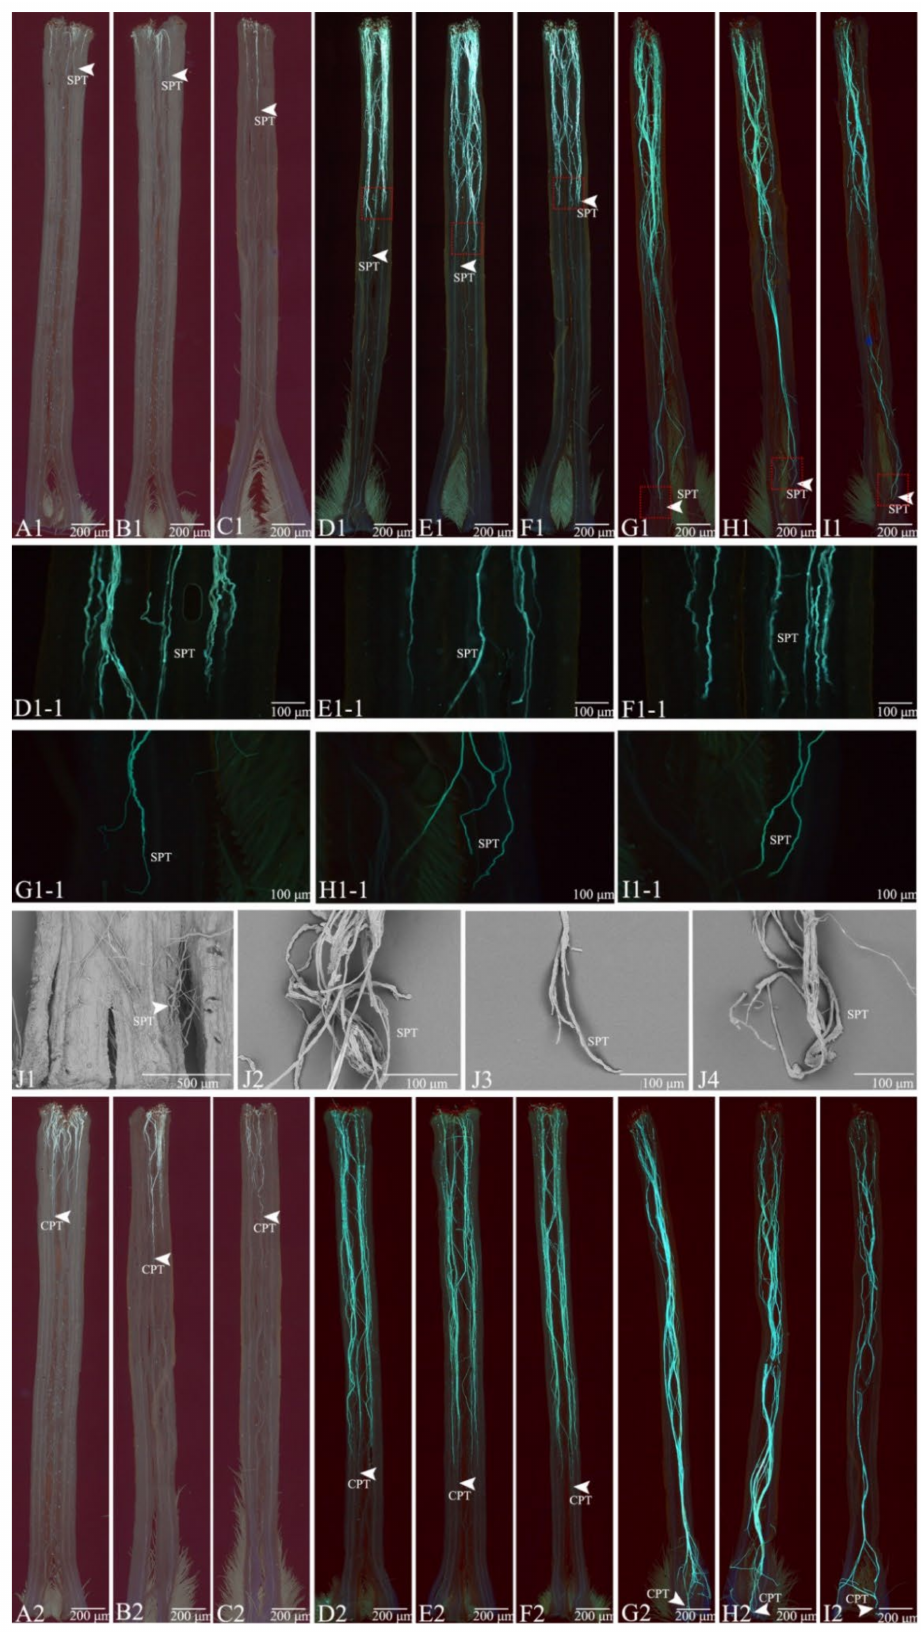
Figure 3. Growth behavior of the selfed and crossed pollen tubes within the style. ( A1 ) style of ‘GW3’ × ‘GW1’ at 24 h after pollination; ( B1 ) style of ‘GW1’ × ‘GW2’ at 24 h after